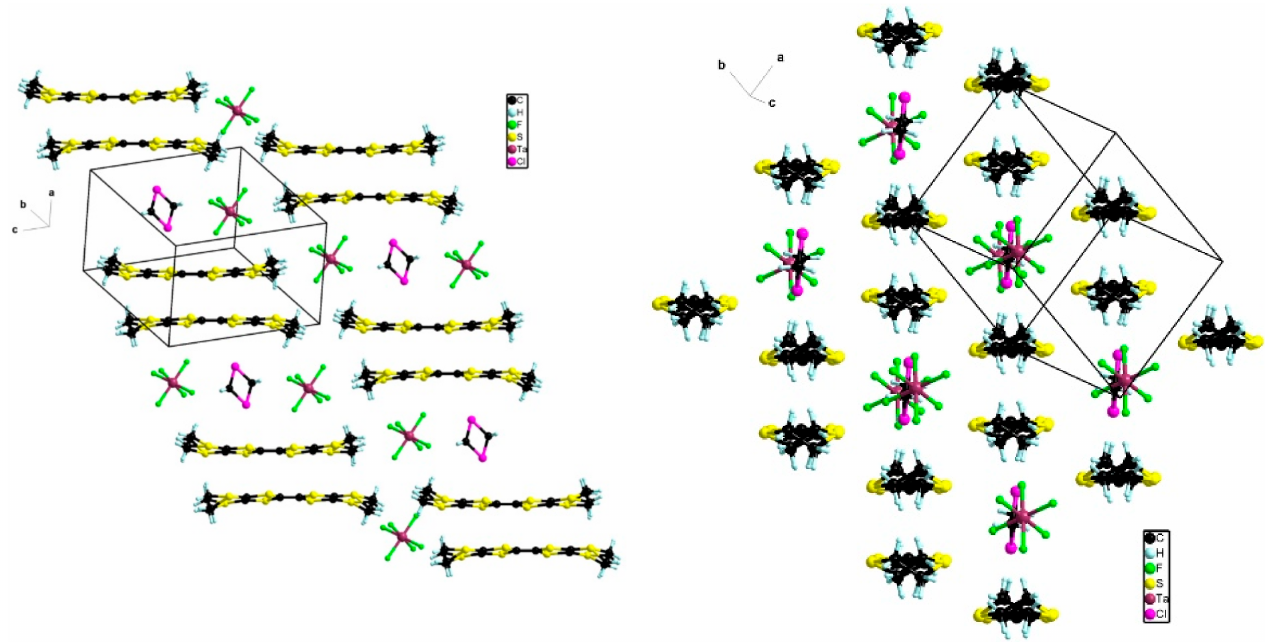
Figure 10. Two views of the packing diagram in the structure of (BEDT-TTF) 2 (TaF 6 ) 2 · CH 2 Cl 2